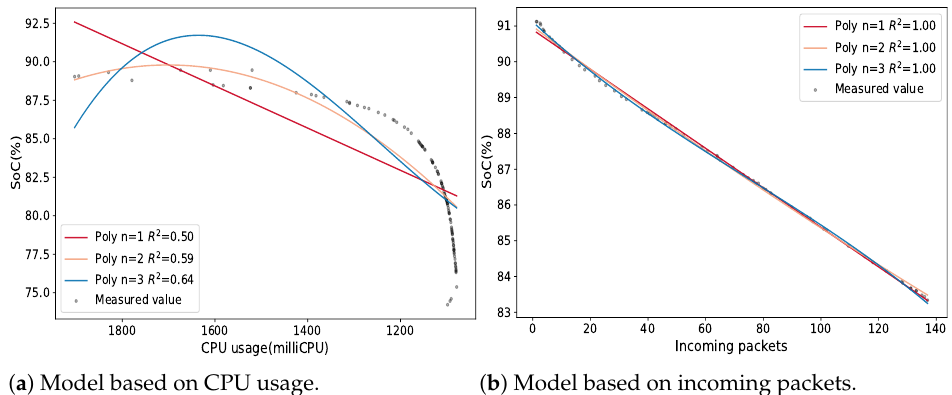
Figure 8. Multiple regression models of the SOC for the control plane node.